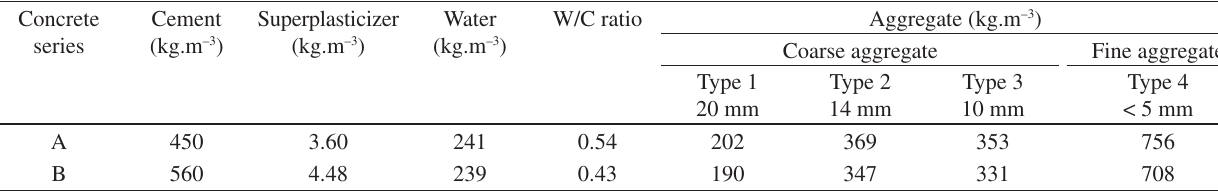
Table 1. Mix proportioning and mix designation of concrete